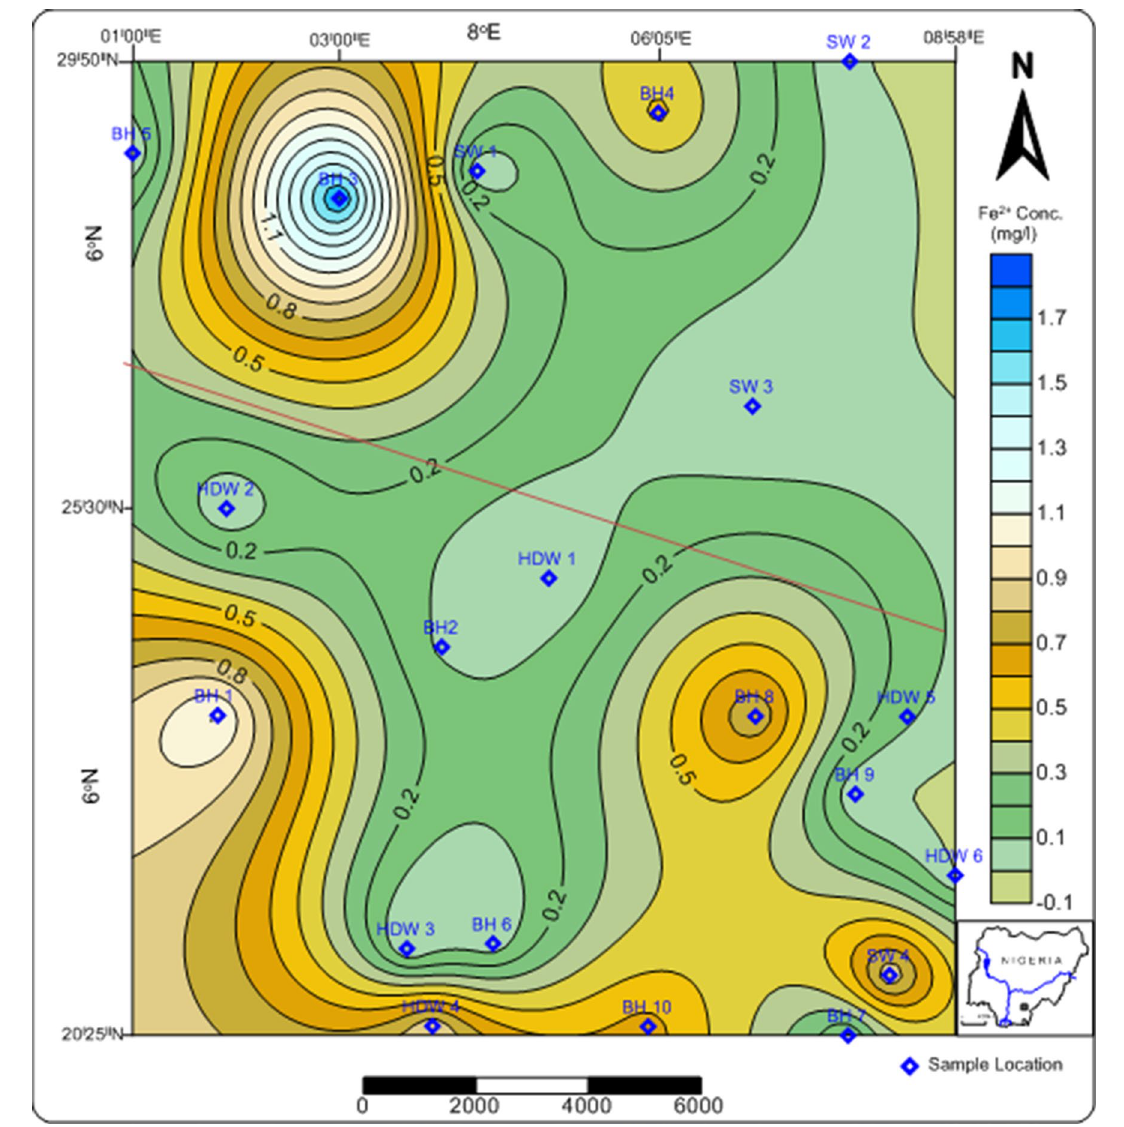
Fig. 23 Dispersion of dissolved iron. Note : Perpendicular line indicates groundwater